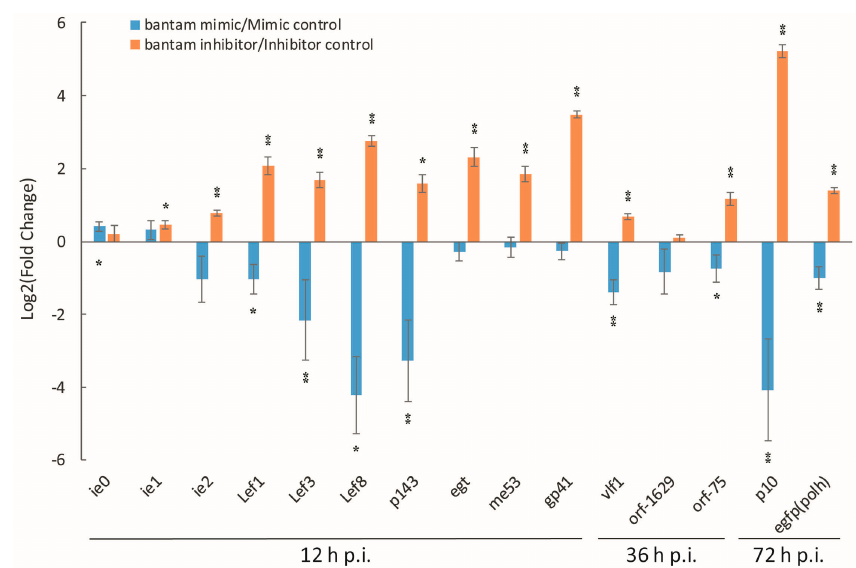
Figure 3. The effect of bantam mimic and inhibitor on the transcription of virus genes in Sf9 cells. Total mRNA was prepared from AcEGFP-infected Sf9 cells in the presence of bantam inhibitor (200 nM) or mimic (400 nM), and the transcription level of representative virus genes was determined with real-time RT-PCR. Cellular tubulin gene was used as the internal control. Sampling time was shown under the gene names. The data was normalized with either inhibitor control or mimic control. The mean of three or more replicates was shown, with the error bars indicating the standard deviation. The significance of difference between bantam mimic and mimic control, or between bantam inhibitor and inhibitor control was also shown (*: p < 0.05; **: p < 0.01).